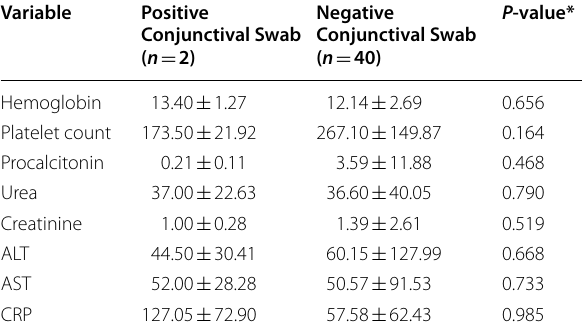
* Independent t-test